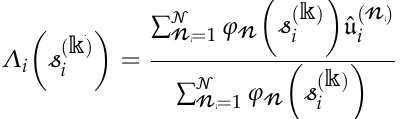
Figure 2. Membership function of fuzzy input of the 𝑖 (cid:3047)(cid:3035) subsystem.